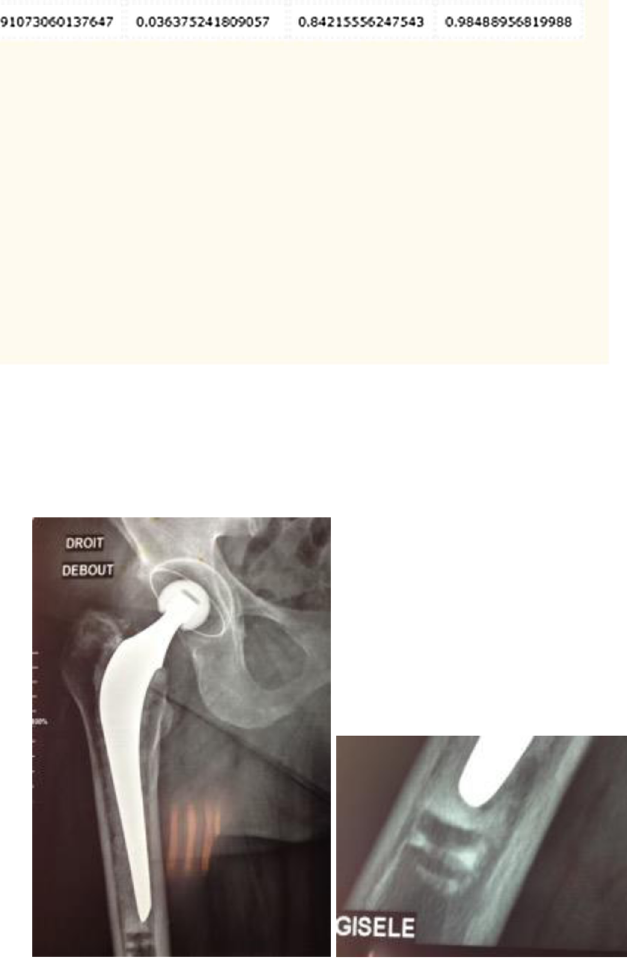
Figure 5. APCR position 2. Traces of cement in APCR are still visible.